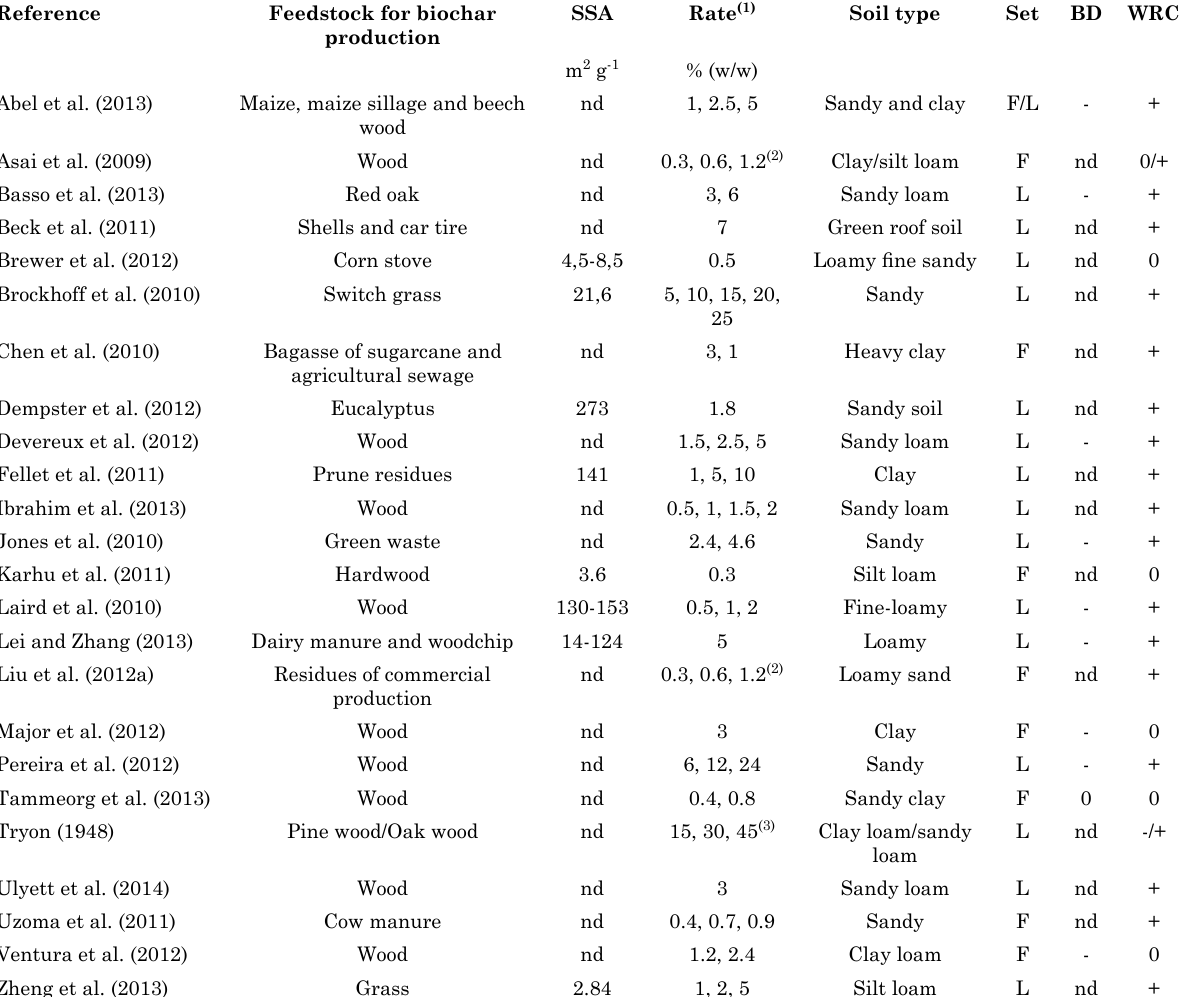
Table 1. The effect of biochar on soil water retention capacity (WRC) and bulk density (BD) under different soil types and experimental conditions